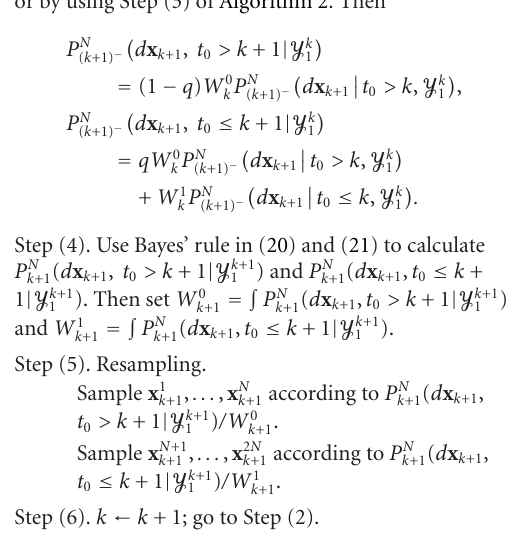
Algorithm 3: Change detection using particle filtering.